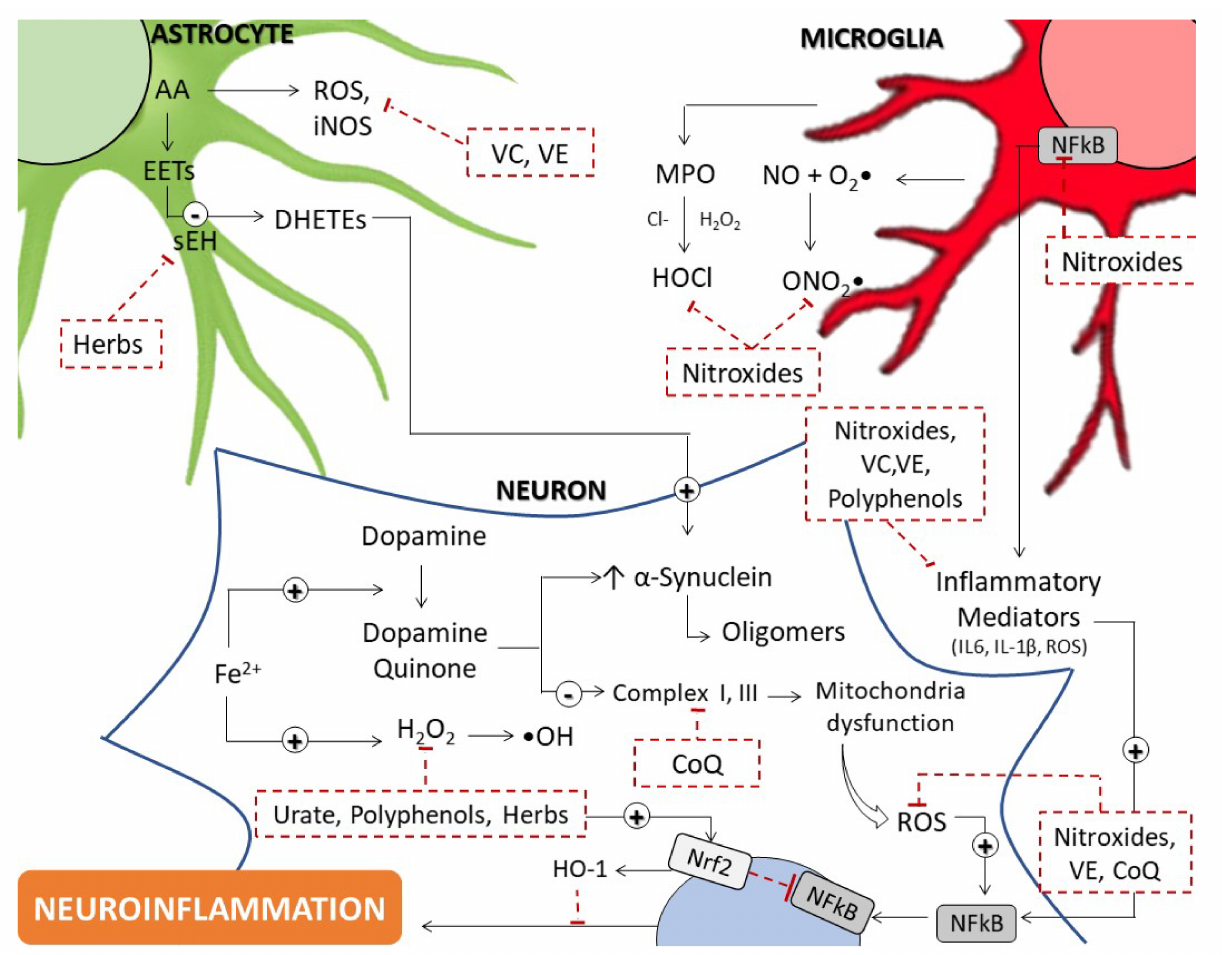
Figure 1. Schematic figure showing the role of oxidative stress, unregulated generation of reactive oxygen species (ROS) and neuroinflammation in the pathogenesis of Parkinson’s Disease. This figure summarizes various molecular pathways identified and implicated in the unregulated generation of ROS, ensuing oxidative stress and inflammatory pathways in neurodegeneration and PD. How natural and synthetic agents target these pathways has led to varying outcomes in experimental models of PD, yet few human trials have shown benefit and in the case of natural herbal therapies, rigorous extensive trials have not yet been conducted. AA: Arachidonic acid, CoQ: Coenzyme Q, DHETEs dihydroxyeicosatrienoic acids, EET: Epoxyeicosatrienoic acid, HO–1: Heme